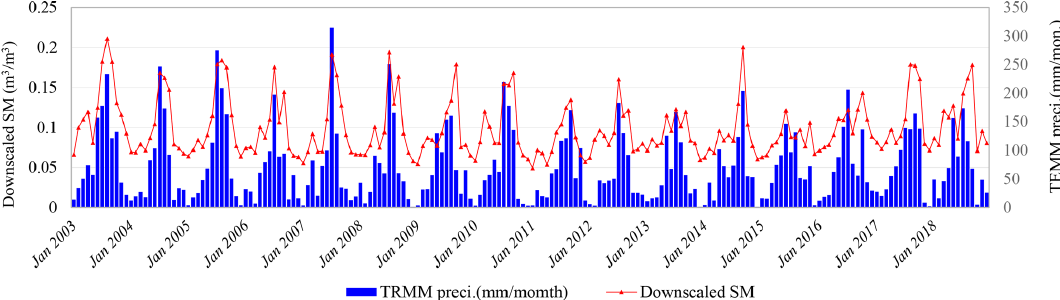
Figure 5. Time series of the area mean downscaled SM and TRMM precipitation during the study period from 2003 to 2018.